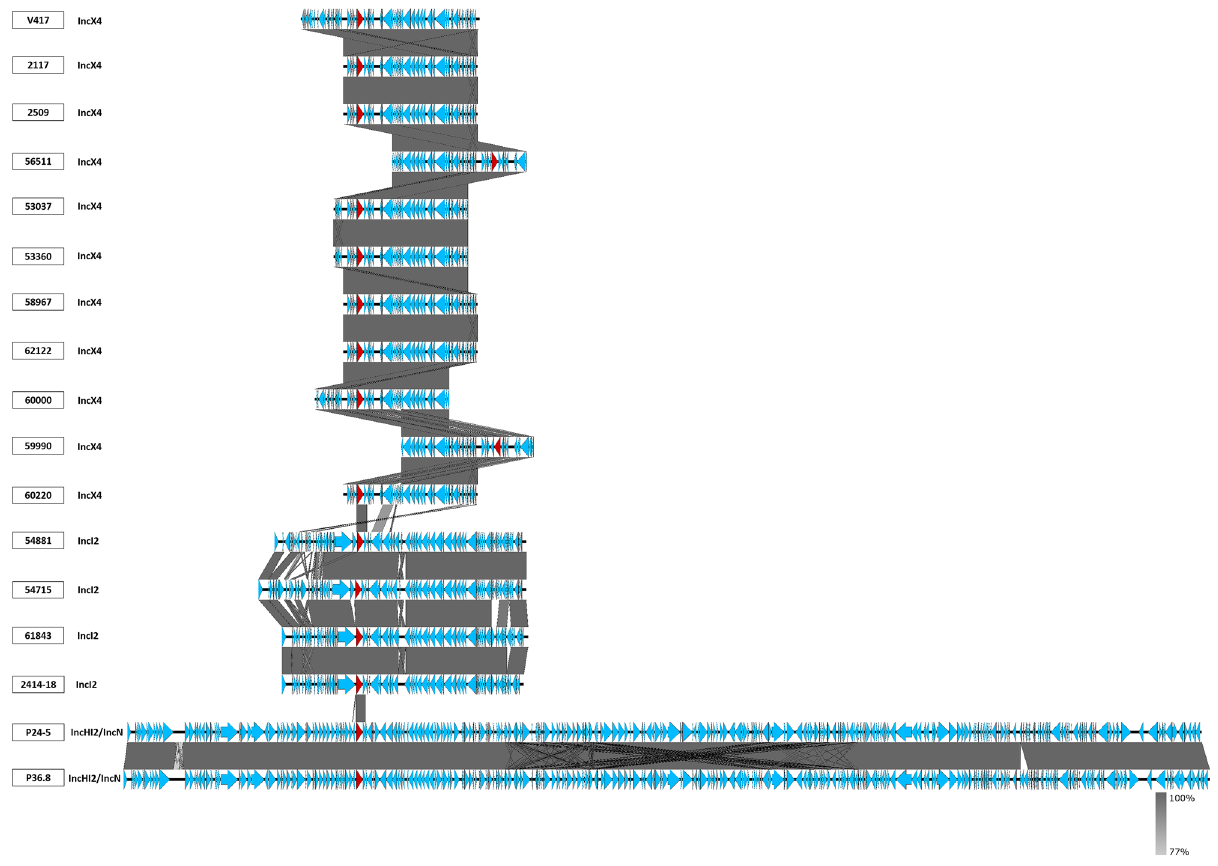
Figure 5. Alignment of plasmids carrying mcr-1 genes. Horizontal red arrows indicate location, size, direction of transcription, and orientation of open reading frames. The red color code indicates mcr-1 . Homologous segments generated by a BLASTn comparison are shown as gray blocks that are connected across